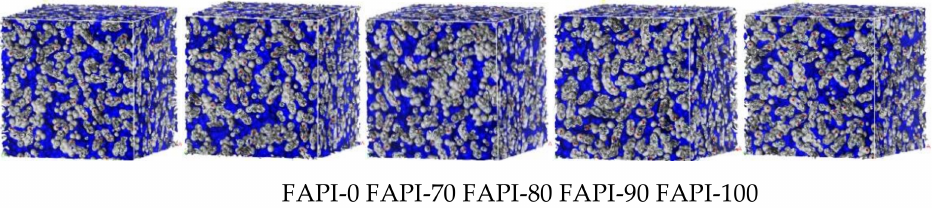
Figure 11. 3D periodic boundary cell of the FAPI films (gray part represents the molecule chain skeleton while blue part represents the free